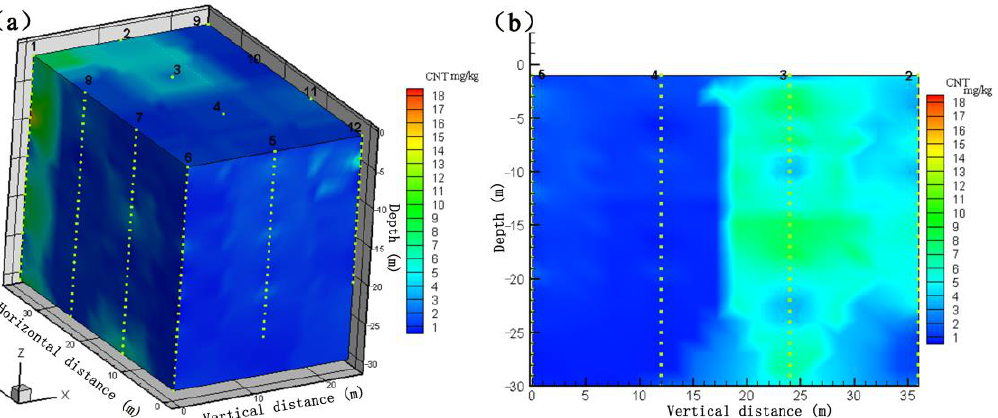
Figure 9. Profile of cyanide concentration distribution in ( a ) vertical and ( b ) horizontal direction in tailings pond.